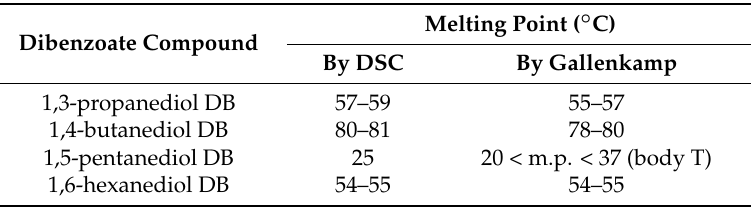
Table 1. Melting points (m.p.) of the four dibenzoate compounds, as established by differential scanning calorimetry (DSC) and by visual observation using a Gallenkamp melting point